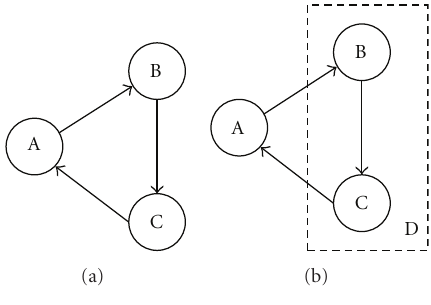
Figure 1: Hierarchical FSMs.